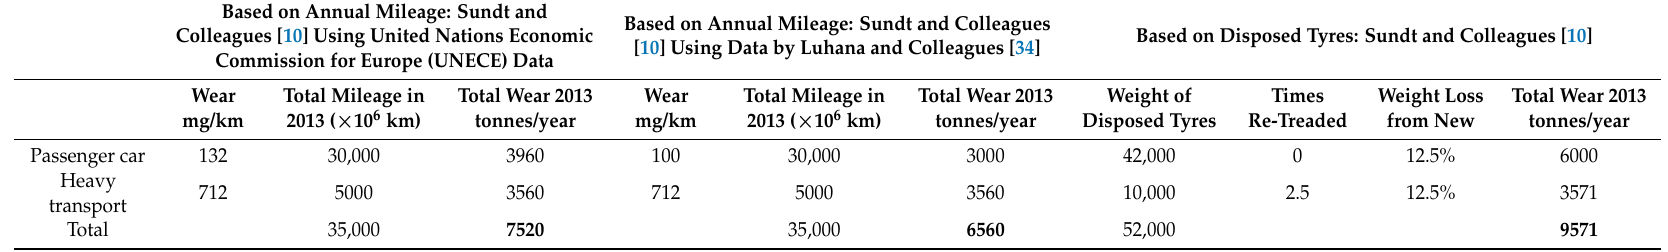
Table 4. Calculation of the amount of tyre wear and tear in Norway [10].